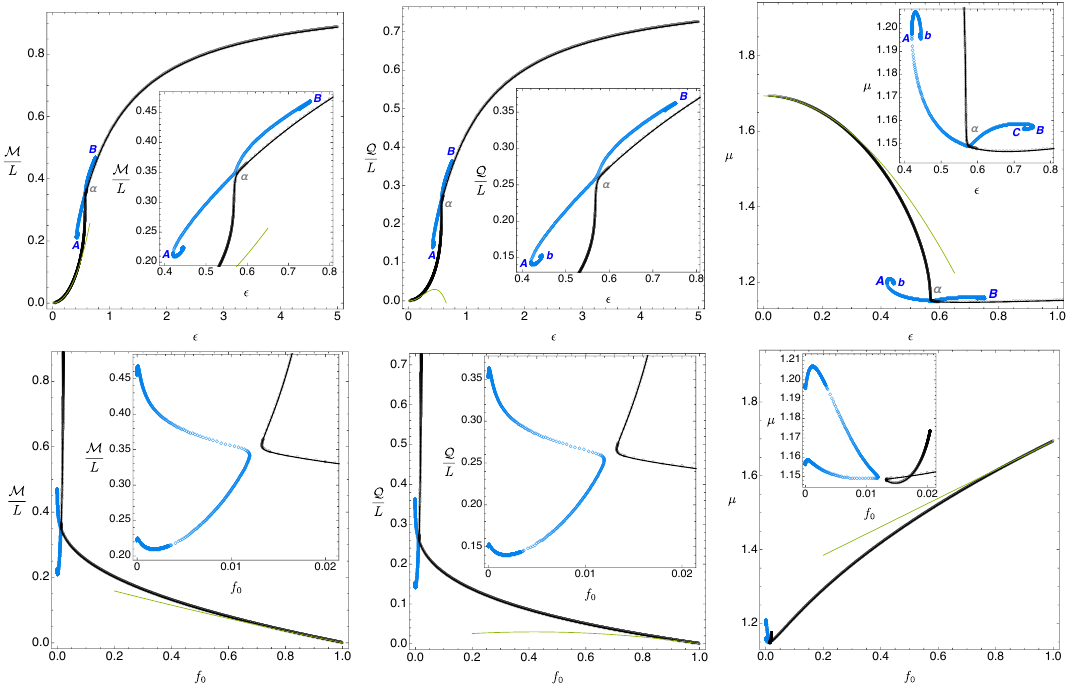
Figure 17 . Soliton families with e = 1 . 855 ( e c < e < e ). Top panel: the quasilocal thermodynamic S quantities, namely mass, charge and chemical potential of the main (black disks) and secondary (blue diamons) soliton families are shown as functions of the scalar field amplitude (cid:15) . Bottom panel: quasilocal mass, charge and chemical potential plotted as functions of f 0